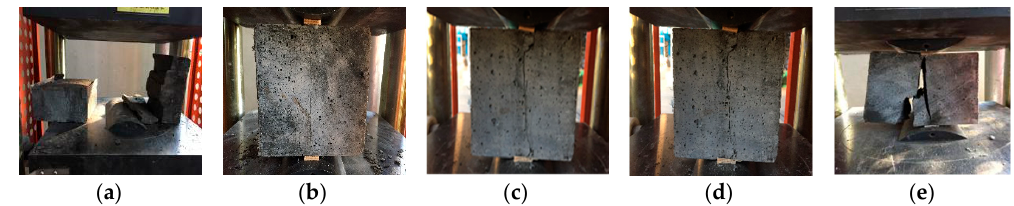
Figure 8. Splitting tensile strength failure mode of polypropylene fiber RPC: ( a ) 0%, ( b ) 0.15%, ( c ) 0.3%, ( d ) 0.45%, and ( e ) 0.6%.